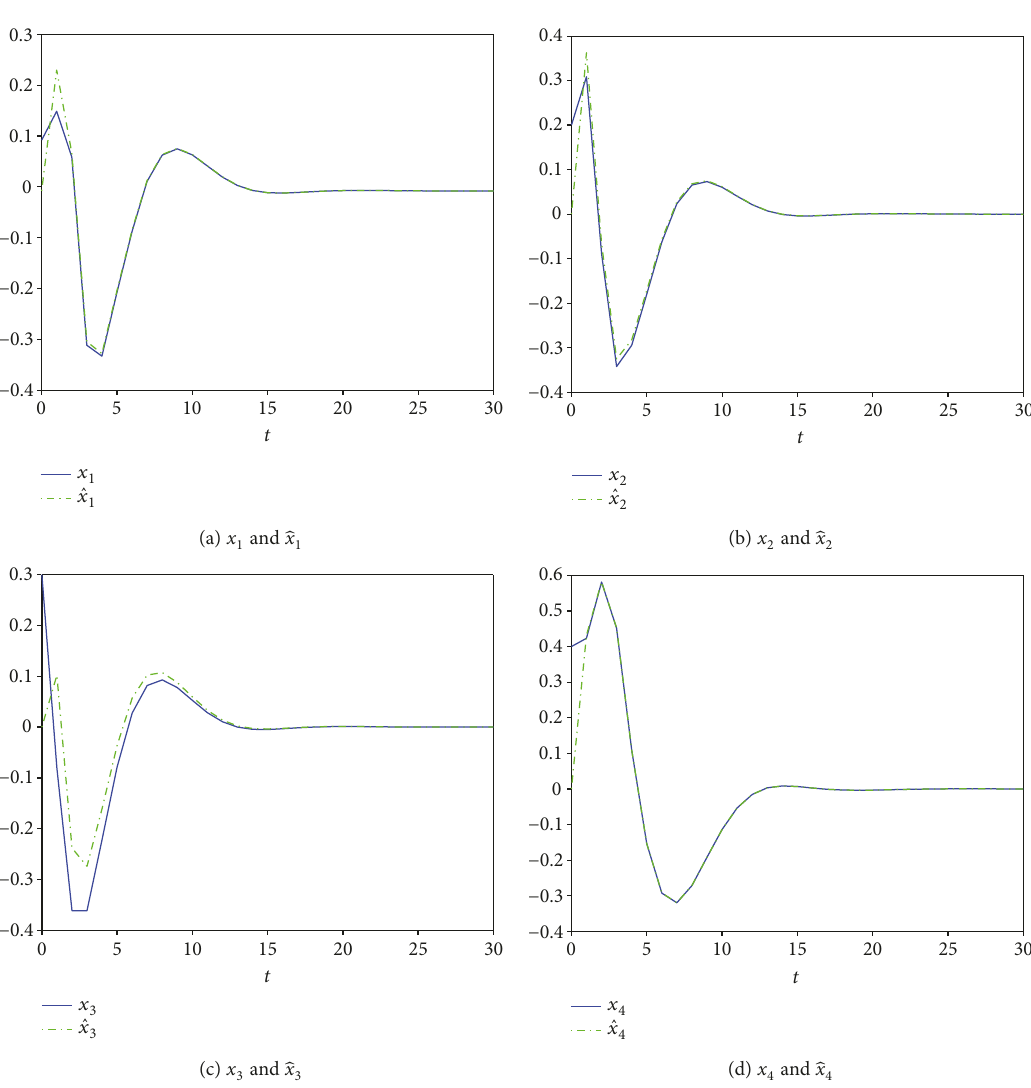
Figure 4: Time responses of the state variables under observer-based fuzzy control.